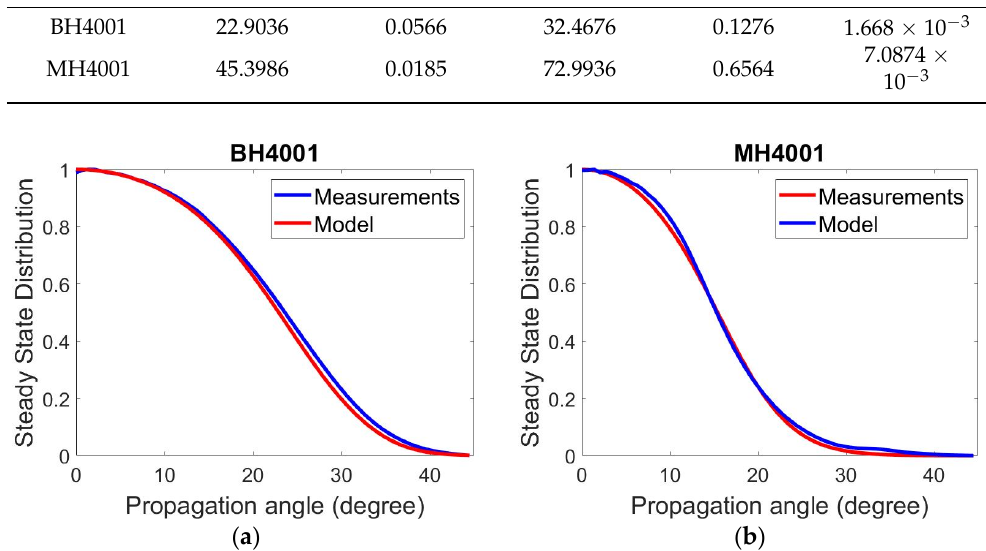
Table 1. Parameters for the fit of the SSD measurements for the BH4001 and MH4001 fibers. Fiber